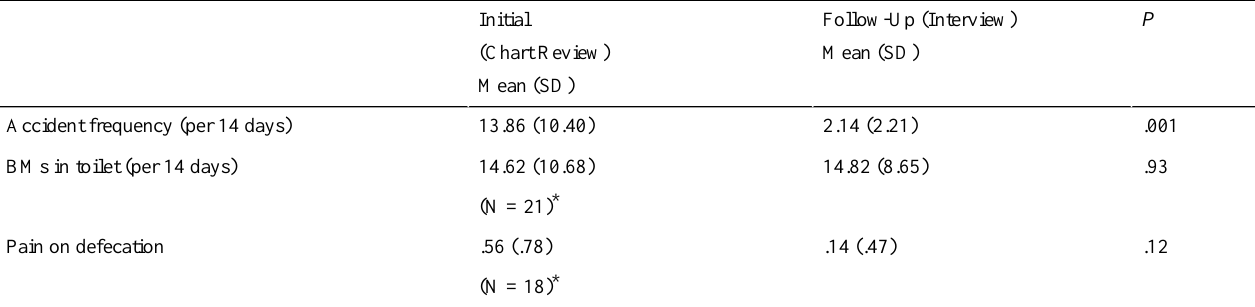
Table 2. Initial to follow-up bowel-related statistics (N =